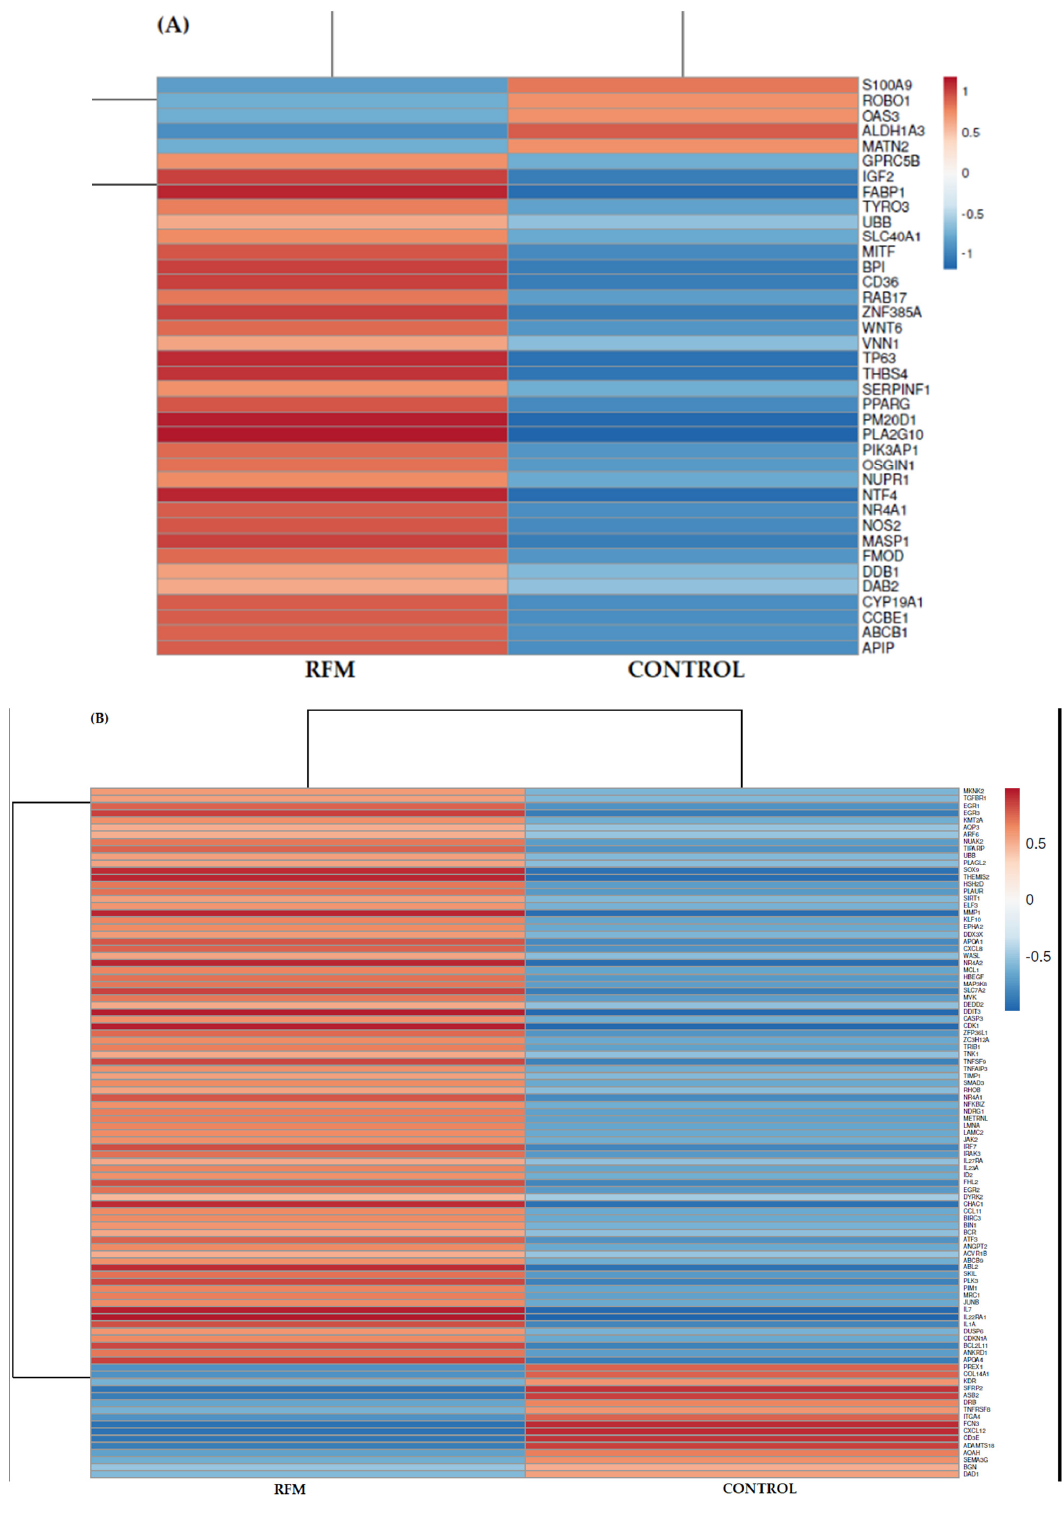
Figure 1. Heatmap showing genes whose expression differs between RFM and control group of mares in the endometrium ( A ) and the allantochorion ( B ). Each row refers to a gene, while columns refer to the investigated groups. Genes with up-regulated expression are shown in red, while with down-regulated in blue. Data were analyzed with the use of ClustVis software [26] and the following parameters: Logarithmic transformation and the Pareto scaling. Table 1. Top five differentially expressed genes (DEGs) in the endometrium and in the allantochorion with their accession numbers, fold change (FC), and corresponding adjusted p -value.